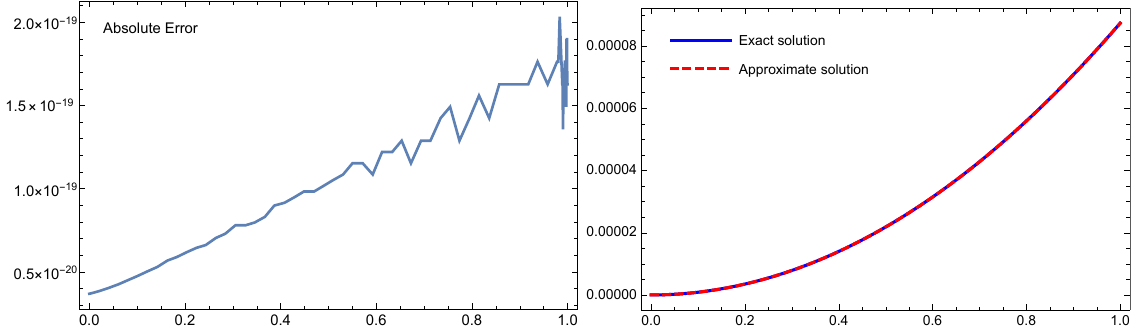
Figure 4. For Example 3, Case I with m = 6: the absolute error is shown on ( left ), the analytic and the approximation solutions are presented on ( right ).